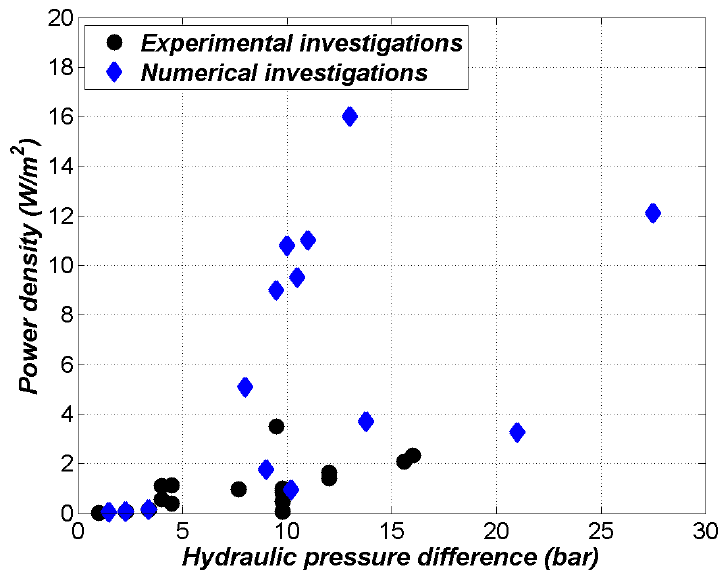
Figure 8. PRO performance from experimental and numerical investigations of a spiral wound module [29,62–69]. The data used in this figure are summarized in Table